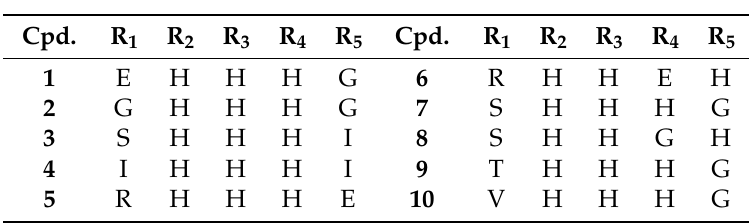
Figure 2. Structures of compounds 1 – 10 .